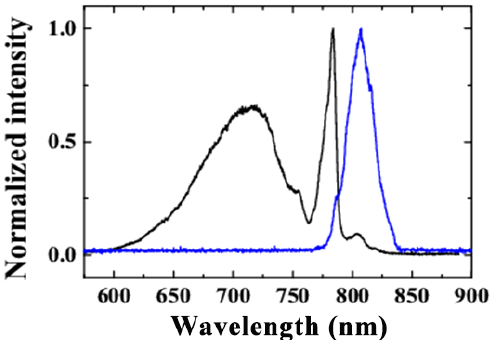
Figure 5. The spectra of the two pump beams, Beam 1 (black curve) and Beam 2 (blue curve) [75].